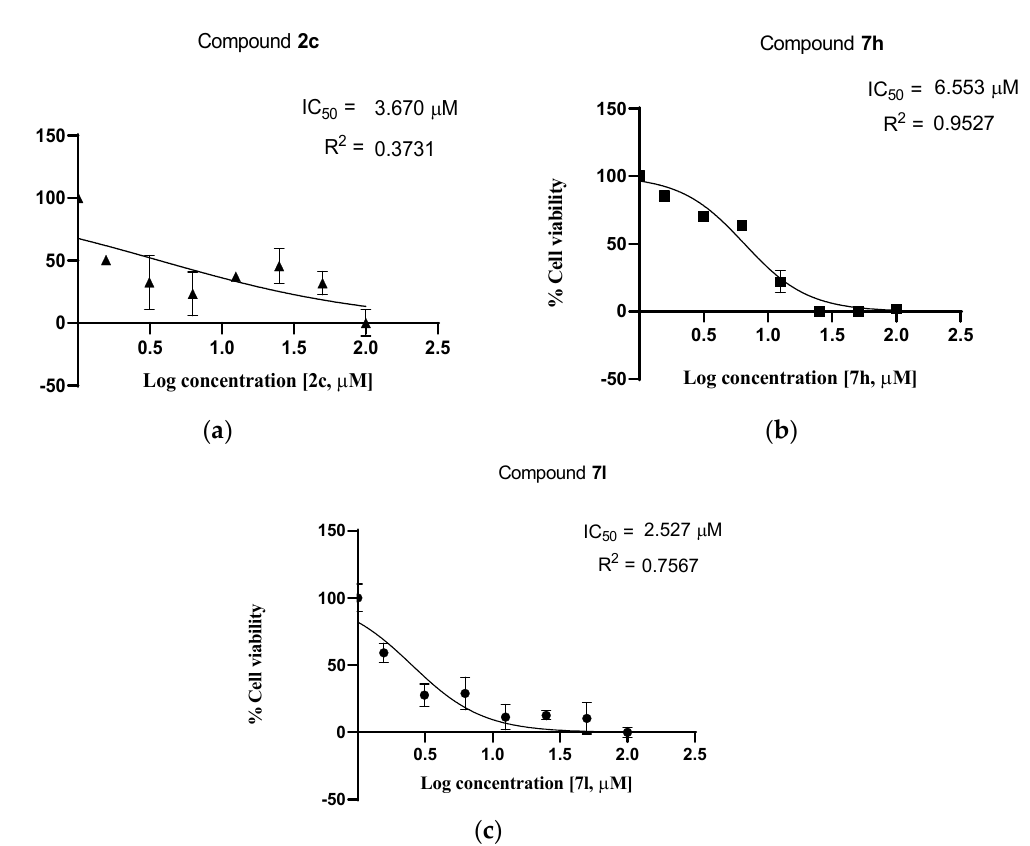
Figure 5 represents the dose–response curves for the compounds 2c , 7h and 7l in HCT116 cells after 72 h incubation.